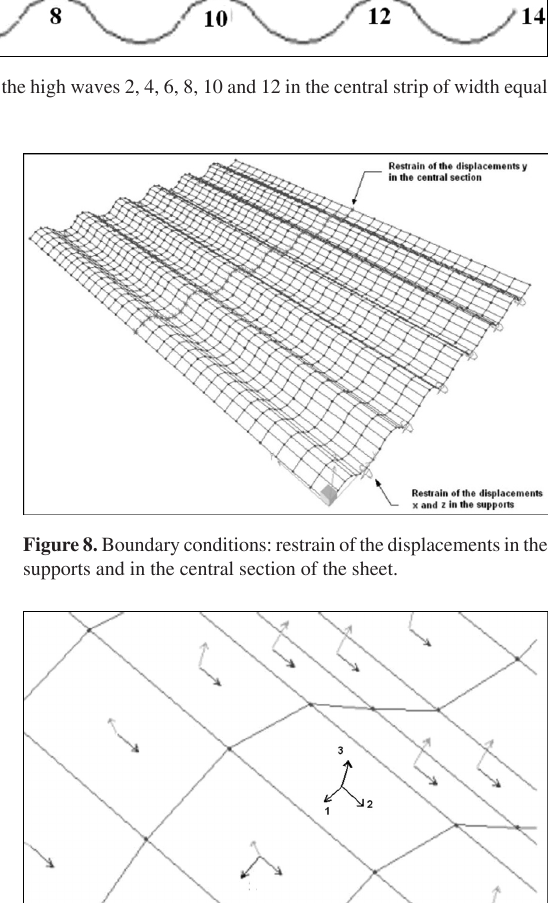
Figure 7. Test apparatus used for determination of the strength of the corrugated sheets 6 .